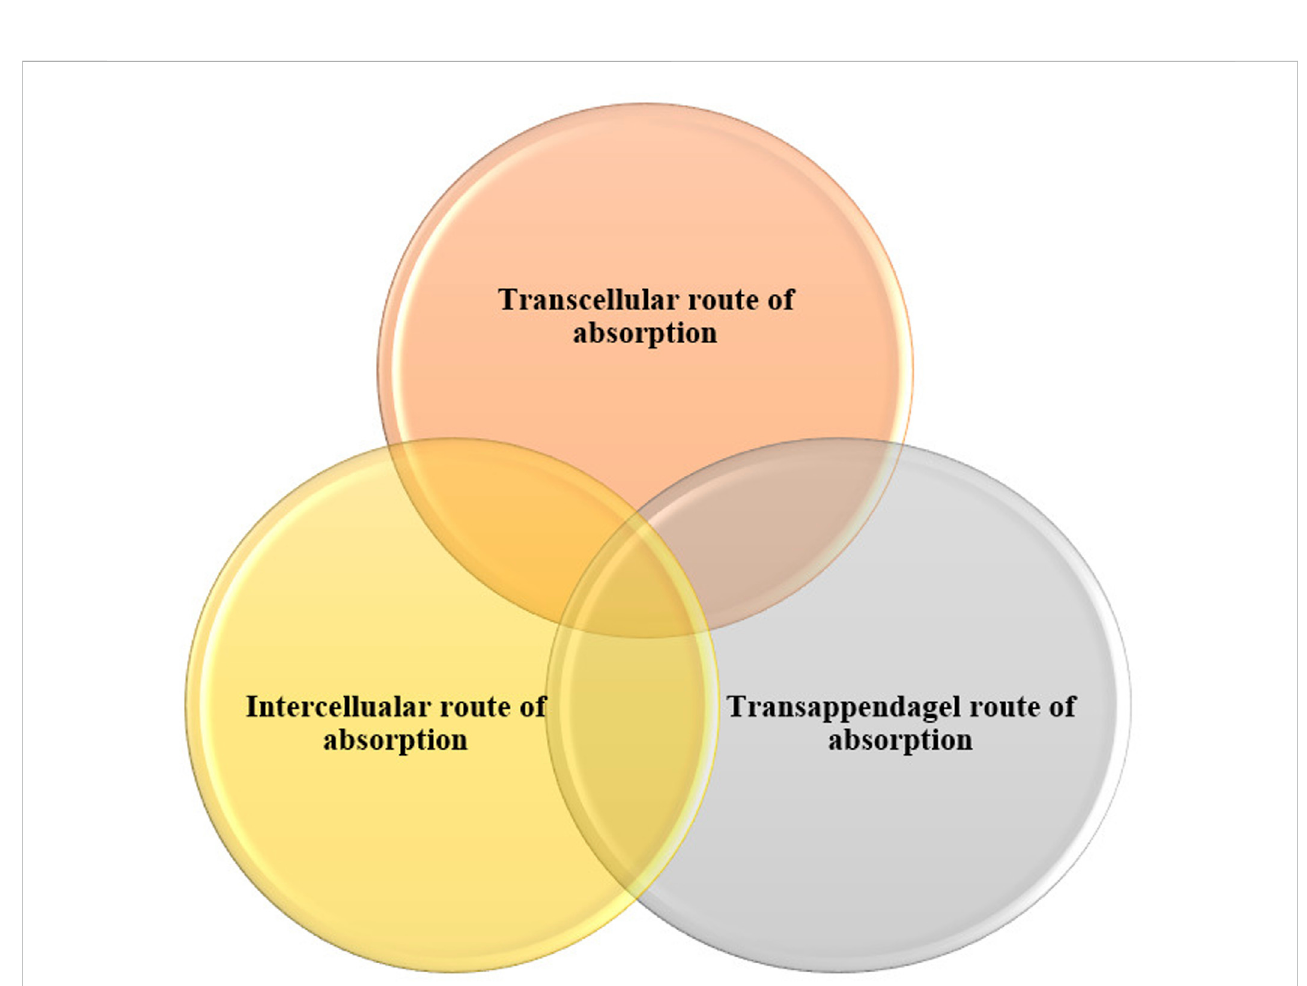
FIGURE 2 Pathways through absorption of drug by